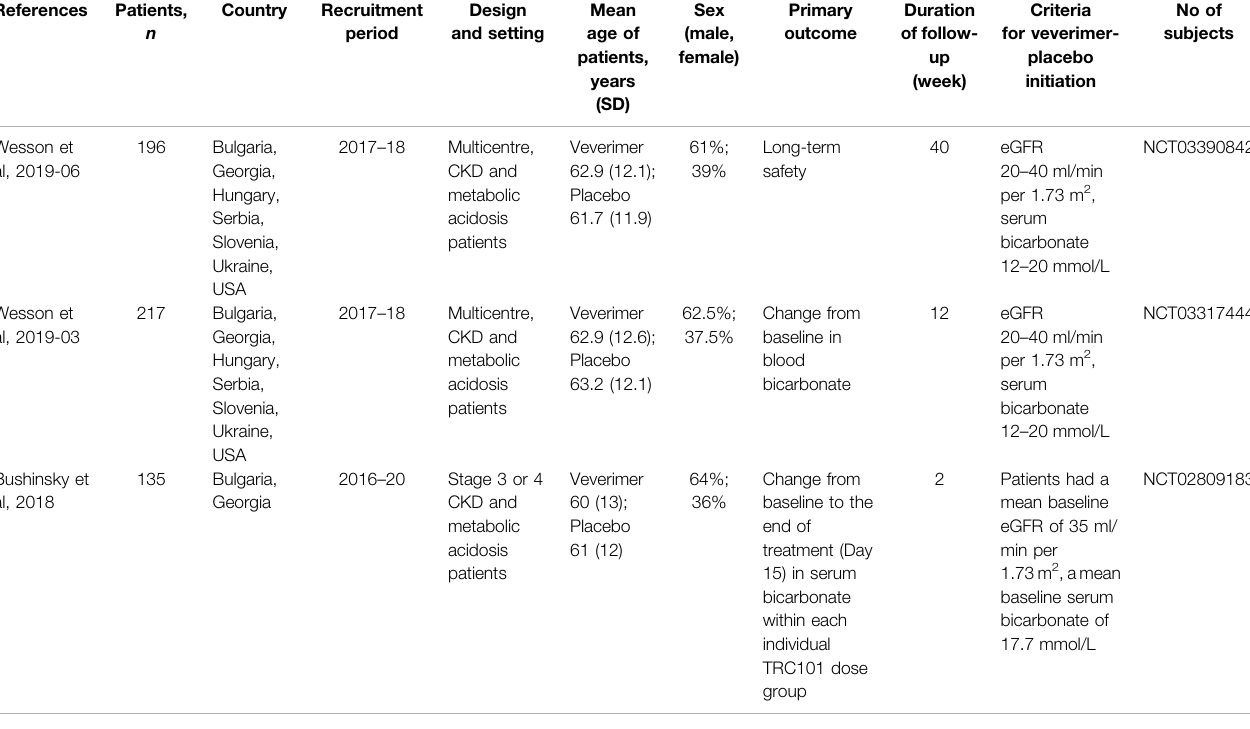
TABLE 1 | Characteristics of included randomized clinical trials.